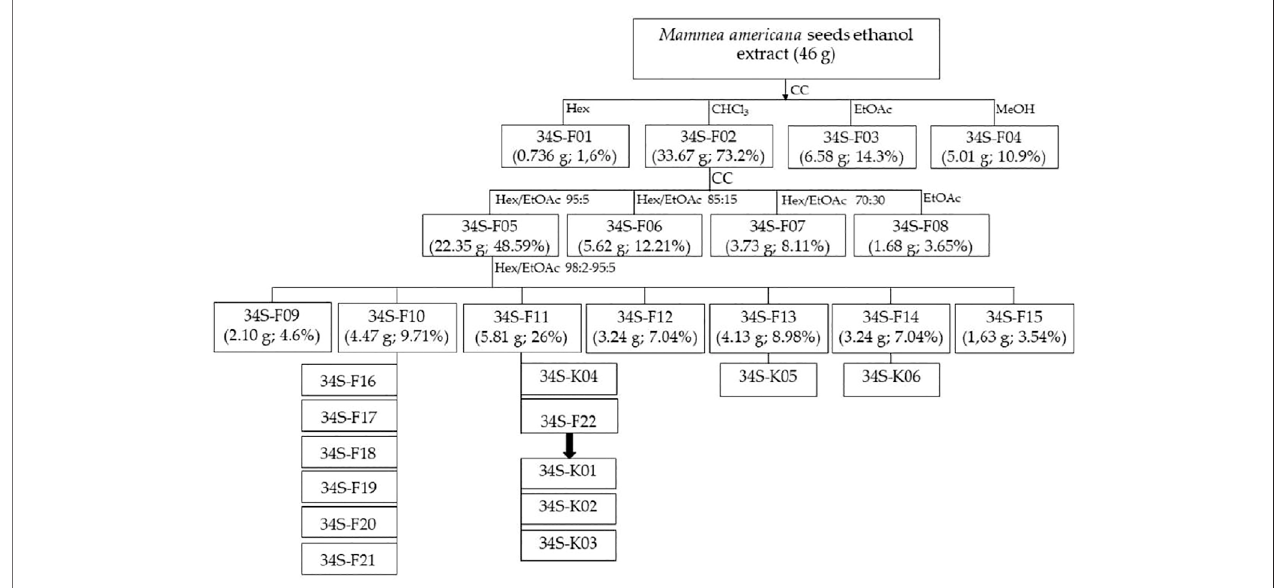
FIGURE 1 | Scheme of the biodirected fractionation of the extract of M. americana seeds. CC, open column chromatography; Hex, hexane; CHCl3, chloroform; EtOAc, ethyl acetate; MeOH, methanol.